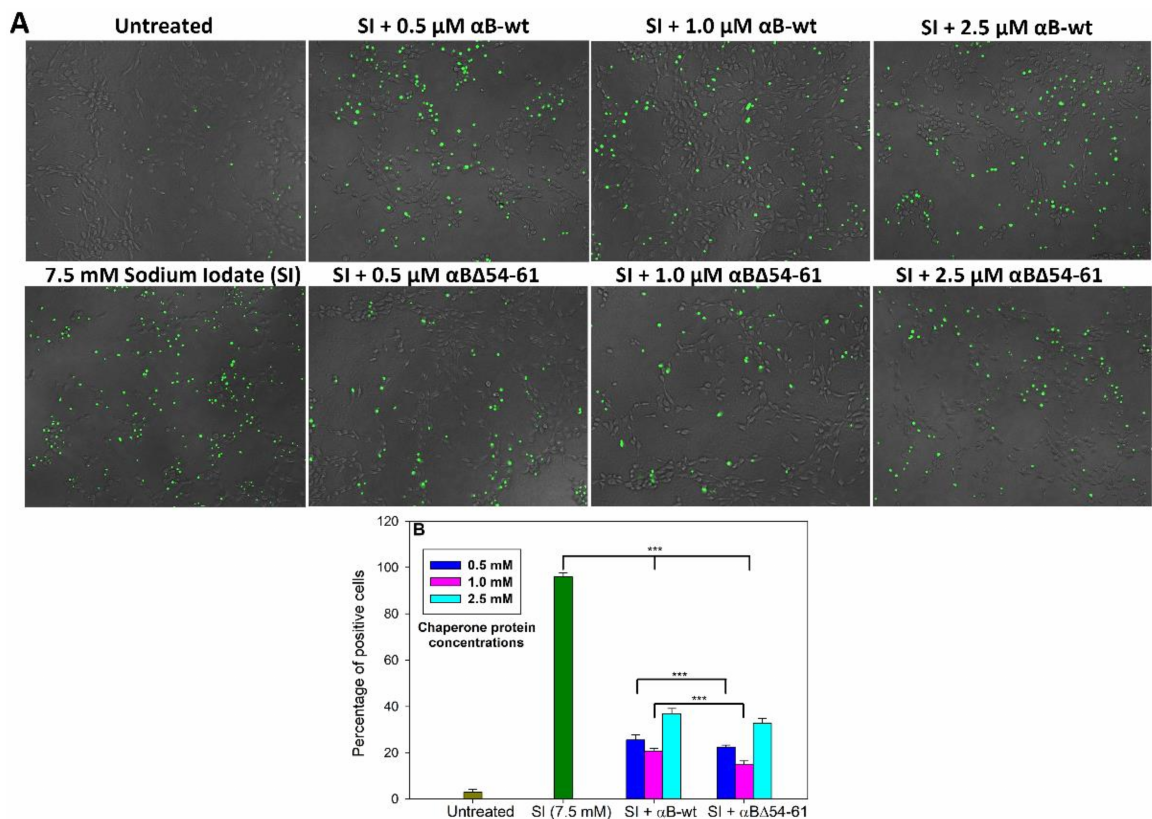
Figure 8. Effect of α B-crystallin sequence 54–61 deletion on caspase activation. ( A ) ARPE-19 cells treated with sodium iodate and/or α B-crystallins and the relative amount of caspase activation was determined after 24 h using NucView 488 Caspase-3/7 assay kit as described under Methods. The images were captured using EVOS FL Auto2 Imaging System in 4 × magnification. ( B ) The percentage of positive cells in each sample was calculated from the cell imaging data using EVOS™ image analysis software (version 1.4.998.659) normalized with the total number of cells in each well. The data show an average of six analyses performed on images captured from different wells for caspase activity in cells simultaneously treated with sodium iodate and α B-crystallins. The asterisks (***) represent a p -value <